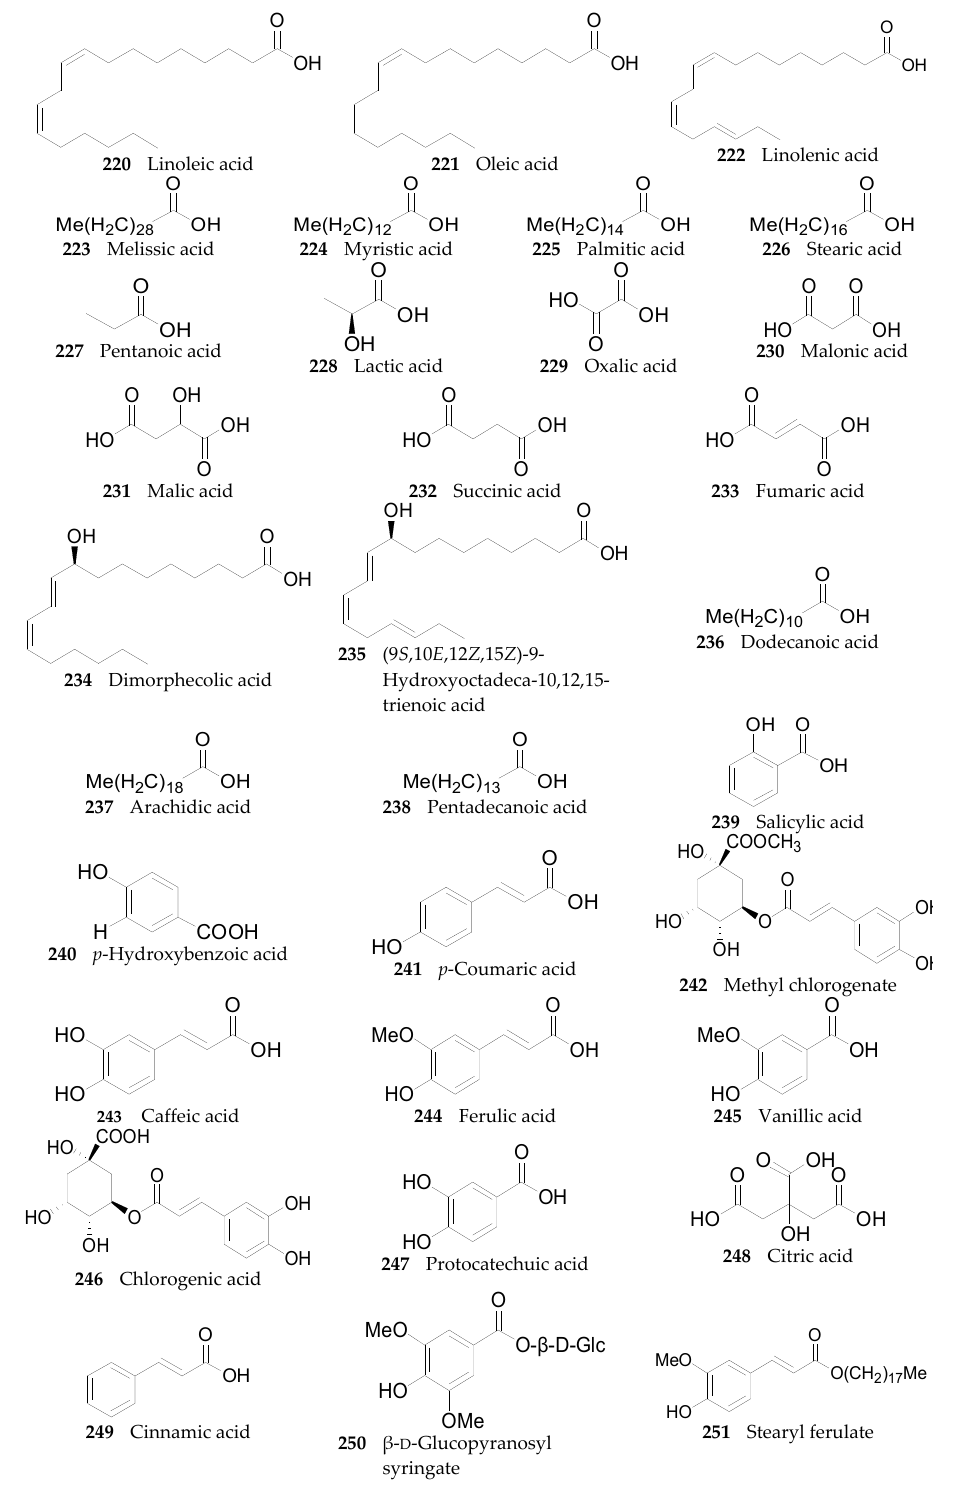
Figure 17. Chemical structures of compounds 216 – 219 .